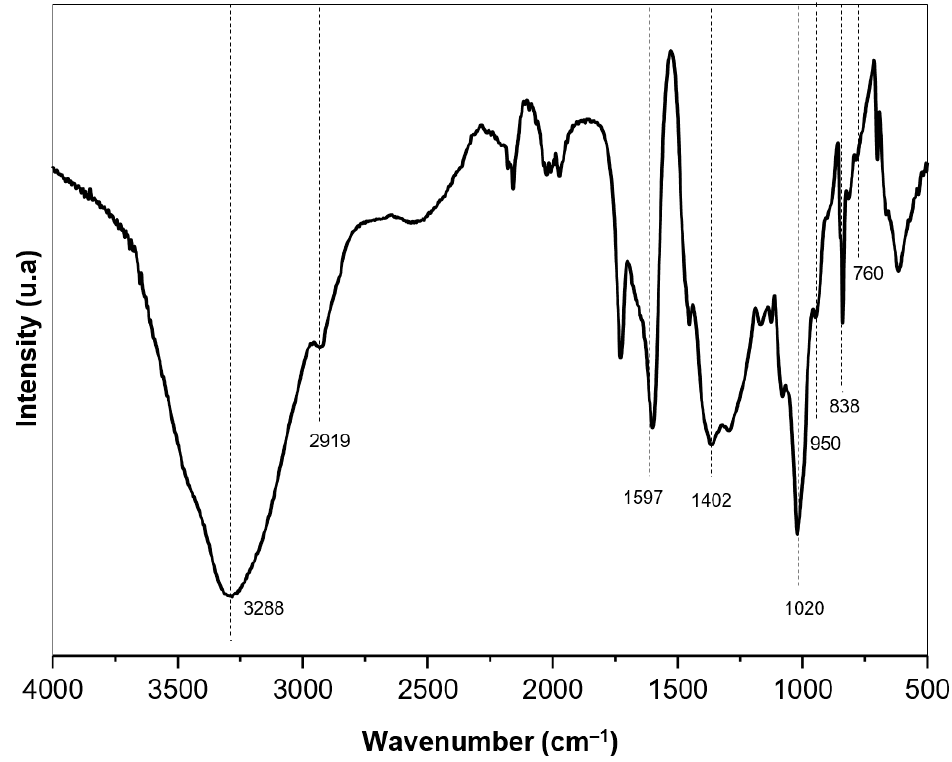
Figure 1. FTIR spectrum of SA from Sargassum